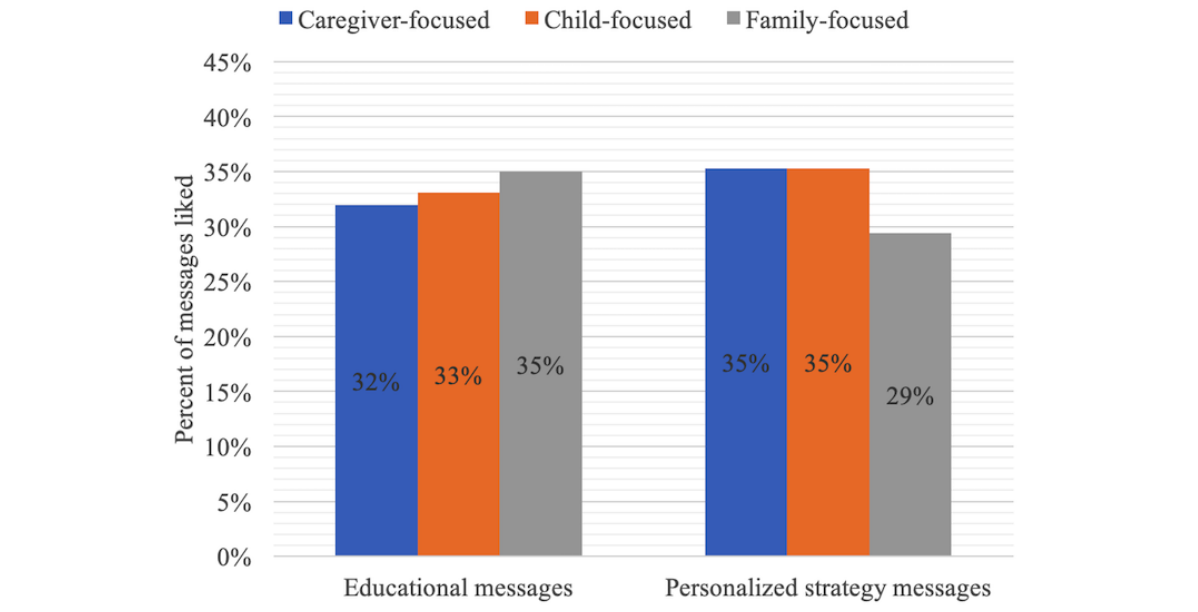
Figure 3. Caregivers’target audience preferences for educational and personalized strategy text messages related to changing sugar-sweetened beverage intake behaviors.